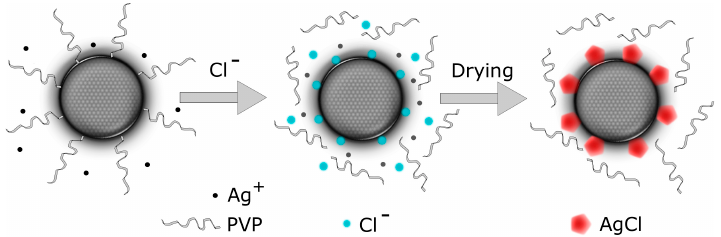
Figure 9. Schematic of proposed AgCl nanocrystal formation on the surface of an AgNP. Chloride ions induce desorption of the PVP capping agents by replacing the PVP anchor group at the AgNP surface. The surface-attached chloride ions act as seeds for AgCl crystals that form under suitable conditions (the presence of free ions, quick absorption/drying).